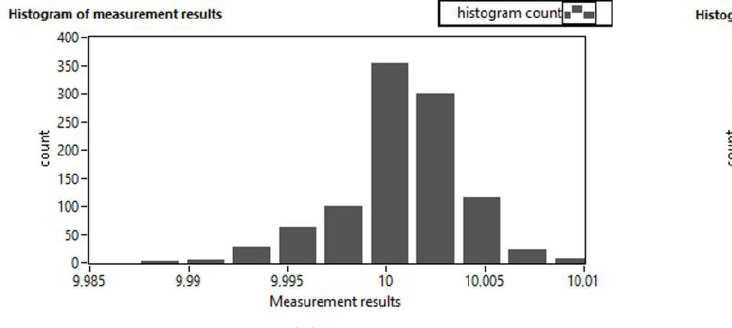
Figure 17. Histograms of individual results from a series of n = 1024 measurements made for the tested module NI USB-6008: ( a ) at low interference level, ( b ) at high interference level.